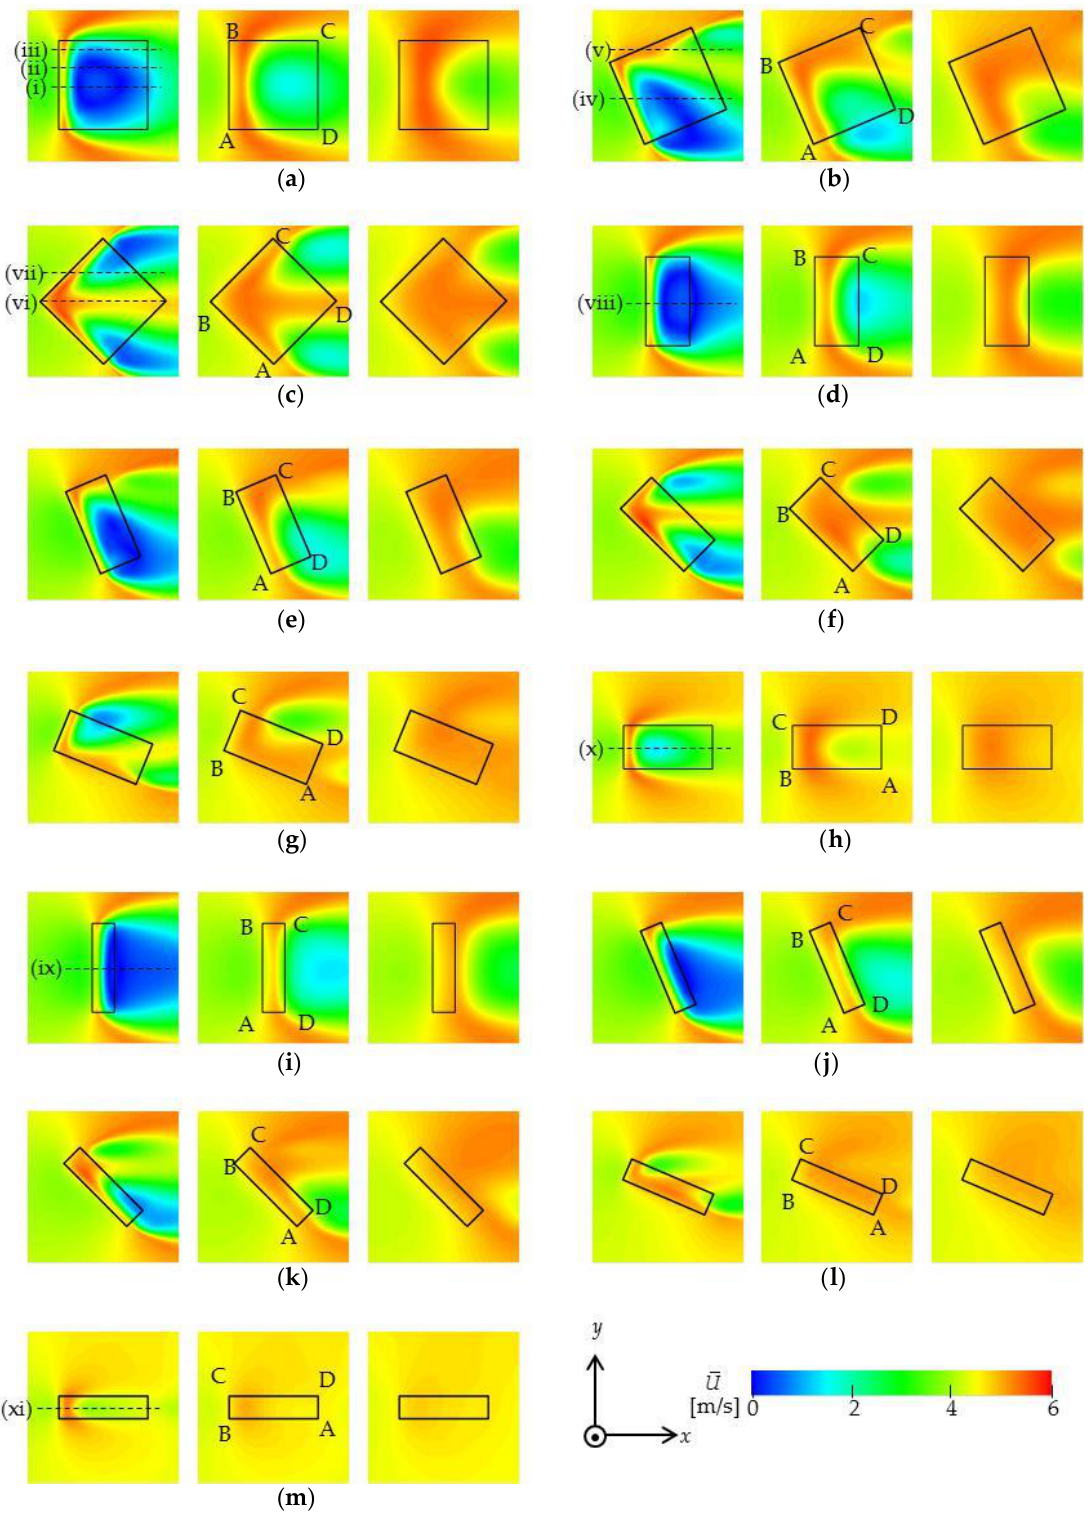
Figure 5. Horizontal distributions of the mean horizontal wind velocity at z / H = 1.05 ( left ), 1.1 ( middle ) and 1.15 ( right ). ( a ) Case 100_000; ( b ) Case 100_225; ( c ) Case 100_450; ( d ) Case 050_000; ( e ) Case 050_225; ( f ) Case 050_450; ( g ) Case 050_675; ( h ) Case 050_900; ( i ) Case 025_000; ( j ) Case 025_225; ( k ) Case 025_450; ( l ) Case 025_675; ( m ) Case 025_900.